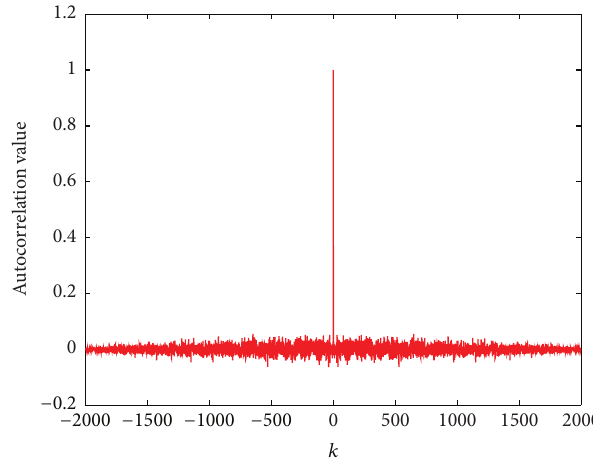
Figure 4: Autocorrelation of chaos sequence for 𝜇 = 4 , 𝑥 0 = 0.329999 , and 𝑁 = 2000 .